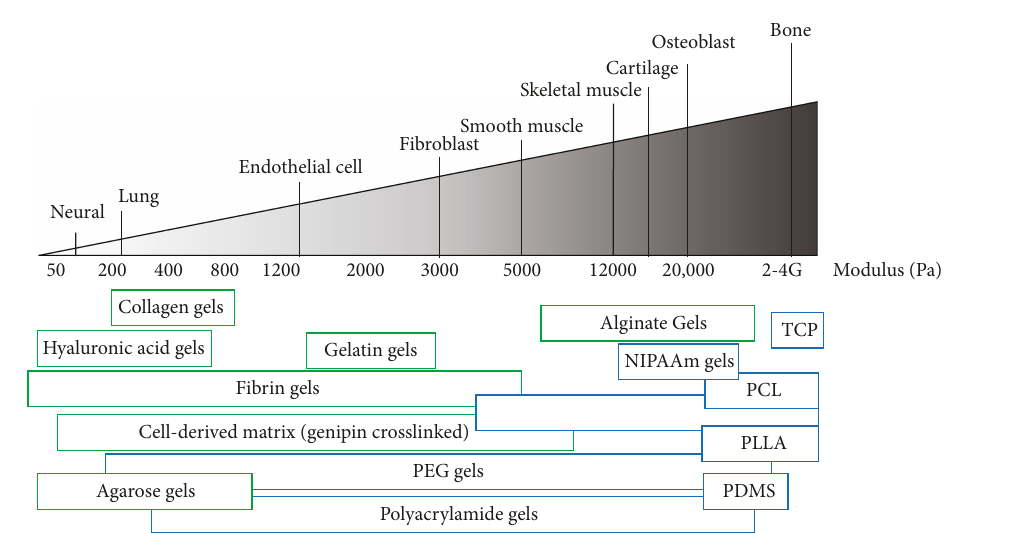
Figure 2: Tissue sti ff ness in vivo , adopted fi gure from Butcher et al. [51], and the range of sti ff ness that can be achieved by natural (green) and synthetic (blue) biomaterials [25, 31, 52 – 70]. Sti ff ness ranges illustrate sti ff ness values reported in the literature, not necessarily the complete sti ff ness range attainable of these